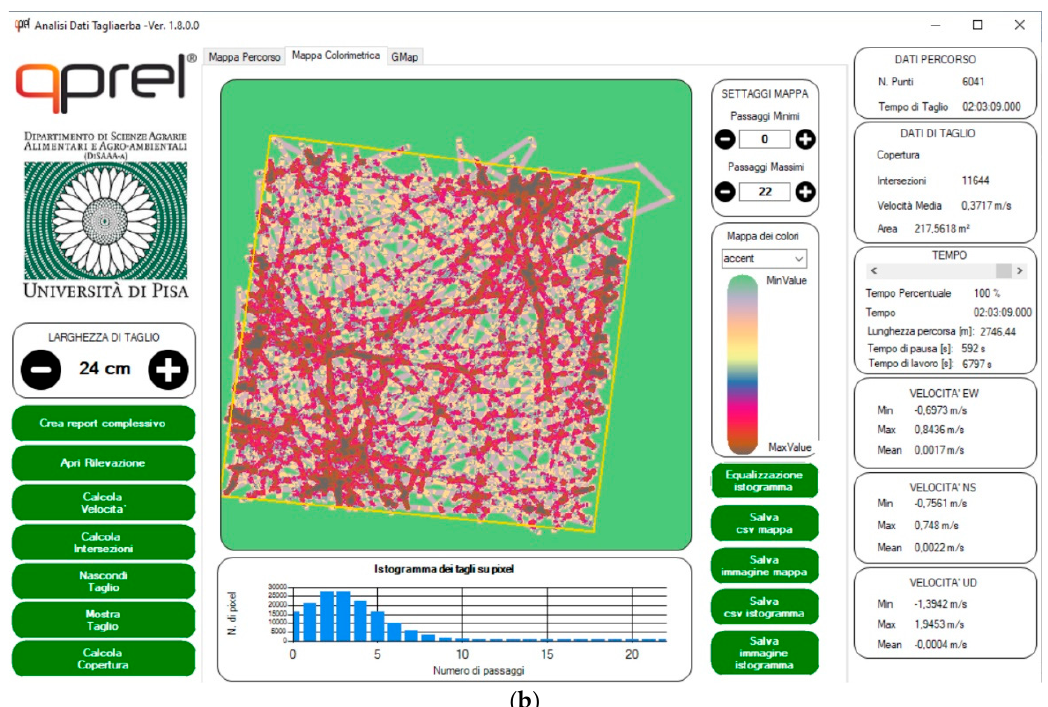
Figure 2. Software functionality: ( a ) calculation of the percentage of area mown on a square obstacle- free area; ( b ) trampling calculation and visualization on a square obstacle-free area.